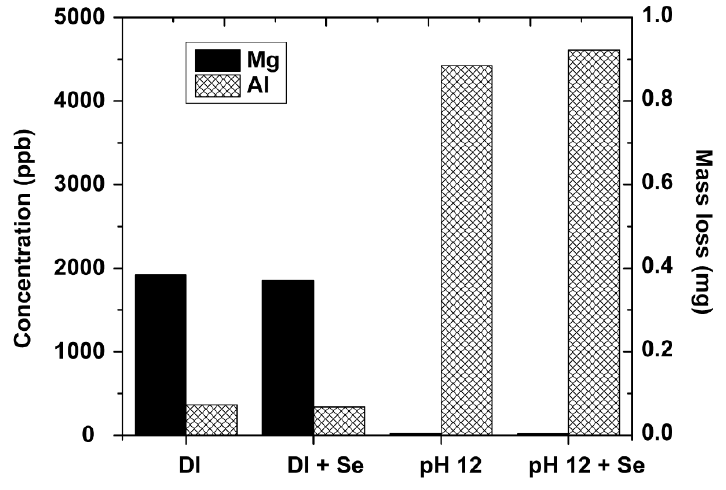
Figure 10. Leaching characteristics of LDH granules. Amount of dissolved Mg and Al after immersing as-obtained granules (0.2 g) in 200 mL of DI water or DI water adjusted to pH 12 with NaOH, with and without 1 ppm Se(VI).